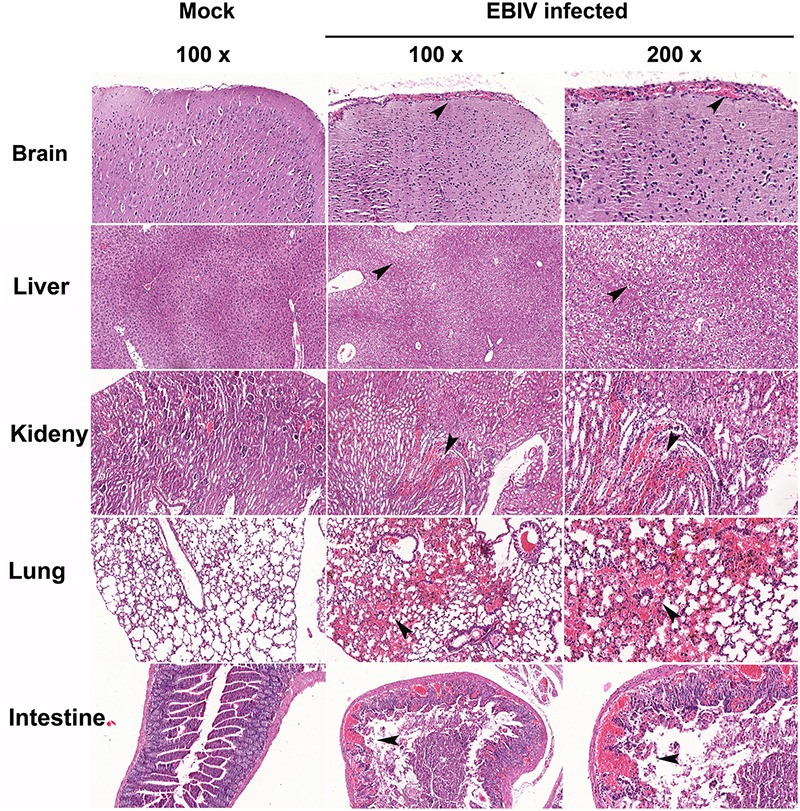
Histopathological features in the organs of EBIV-infected mice. Prominent histopathological changes in the brain, liver, kidney, lung, and small intestine, and vasodilatation and congestion of the blood vessel around meninges have been found. Hematoxylin-and-eosin-stained sections are presented. Original magnification was 100× in tissues of mock-infected, 100× and 200× in tissues infected with EBIV. The black arrows indicate histopathological changes.